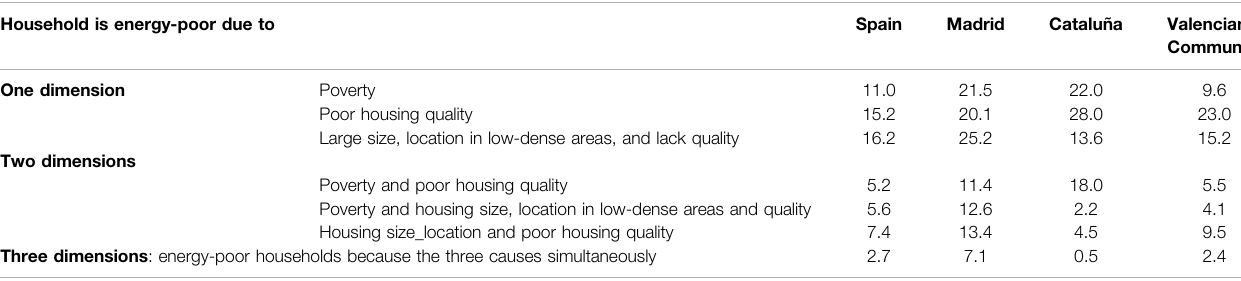
TABLE 5 | Households under energy poverty (EP) (in % of total